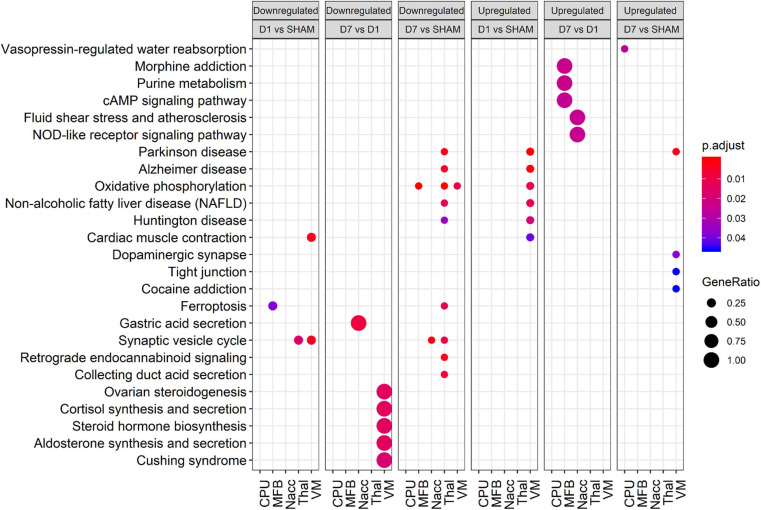
Bubble plot showing enriched KEGG pathways for various comparisons in each tissue. Rows and columns represent KEGG terms and comparisons, respectively. Bubble size and color reflect gene ratio and significance. Only terms with adjusted p < 0.05 in at least one condition are shown. Only the top 10 significant terms of each group were plotted.